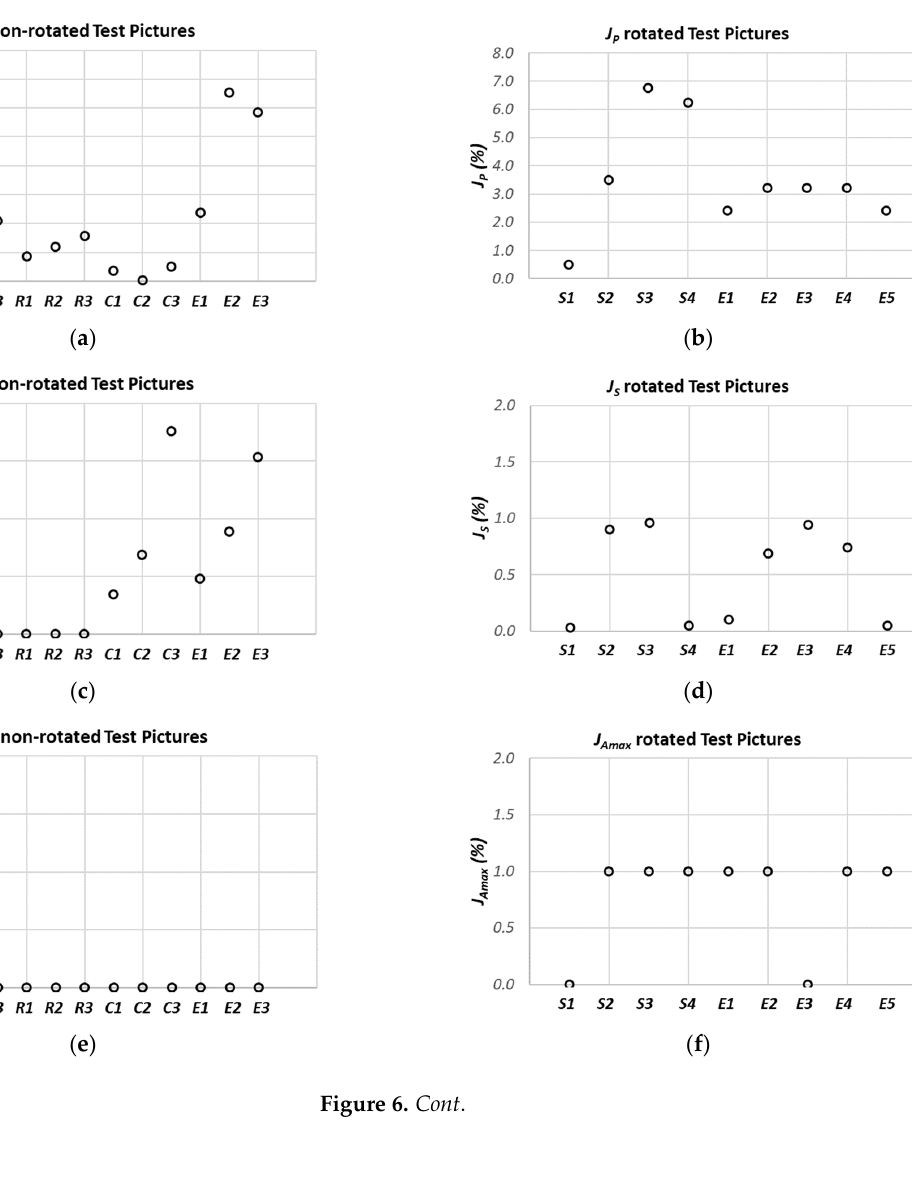
Figure 5. Results obtained for the test images, in terms of mean values (Index (5)) and standard deviations (Index (6)) of the performance Indexes (1)–(4), estimated for each particle core characteristic for the whole set of test particles: ( a ) reference image, ( b ) rotated image.